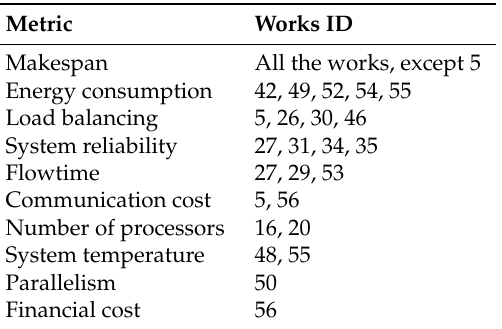
Table 6. Performance metrics for the